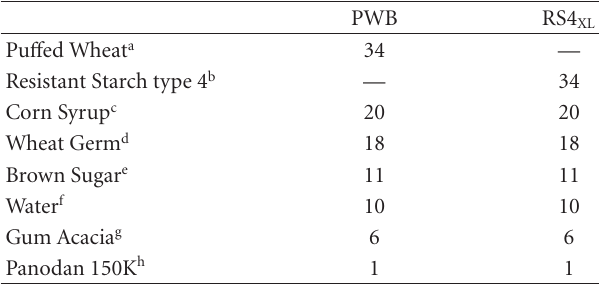
Table 1: Ingredients and their concentrations by relative weight (% total) in the test